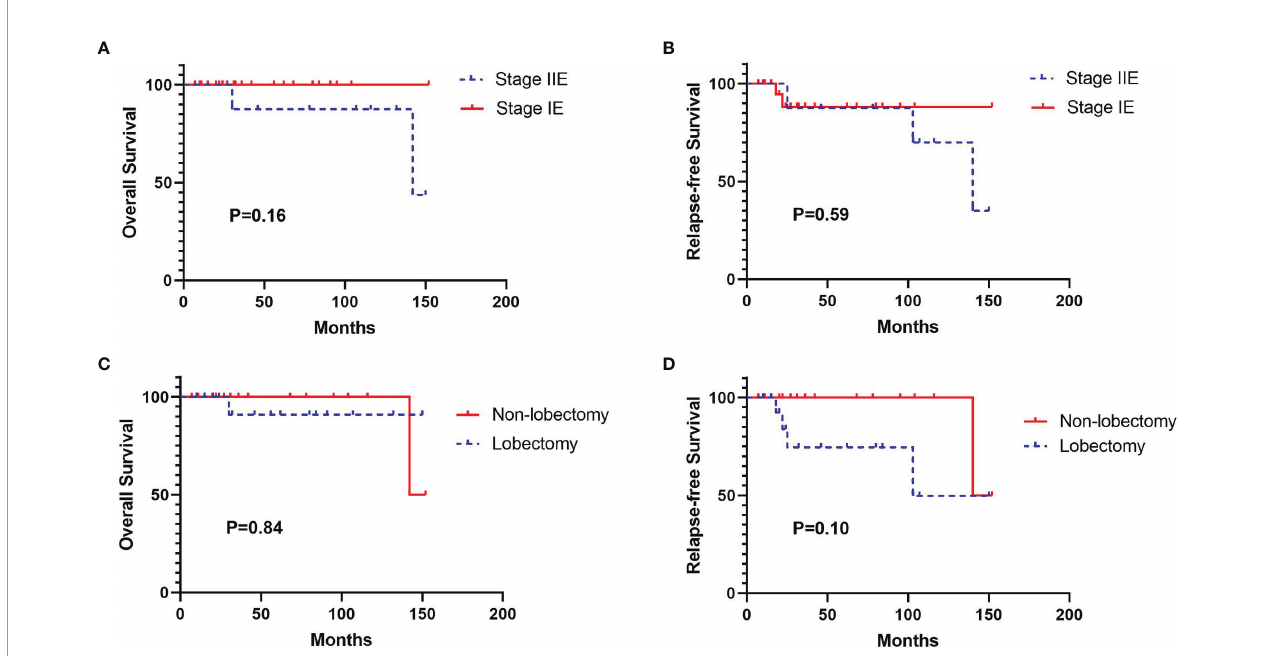
FIGURE 3 | Kaplan-Meier survival curves for overall survival (OS) and relapse-free survival (RFS) according to tumor stage and surgery type. (A) OS curve according to tumor stage, (B) RFS curve according to tumor stage, (C) OS curve according to surgery type, (D) RFS curve according to surgery type.